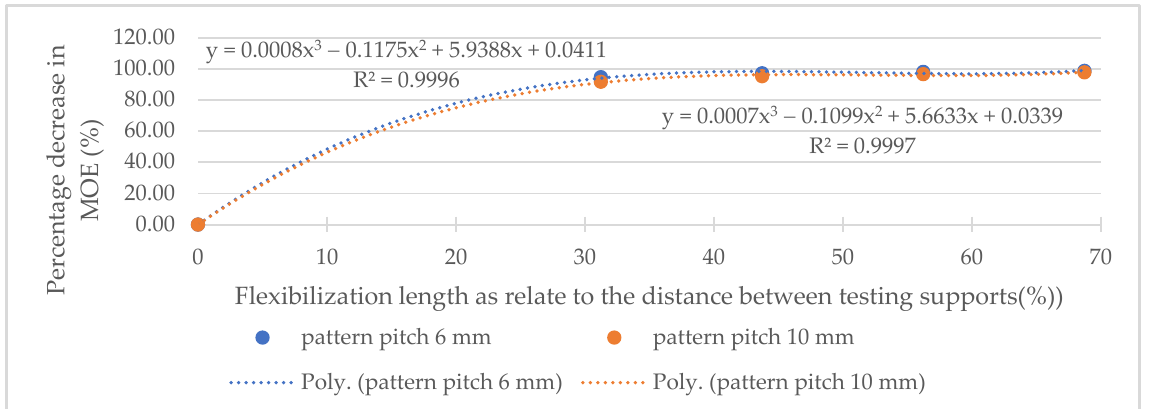
Figure 14. Correlations between percentage change in the MOE with changes in the flexibilization length, for two values of the kerfing pitch.